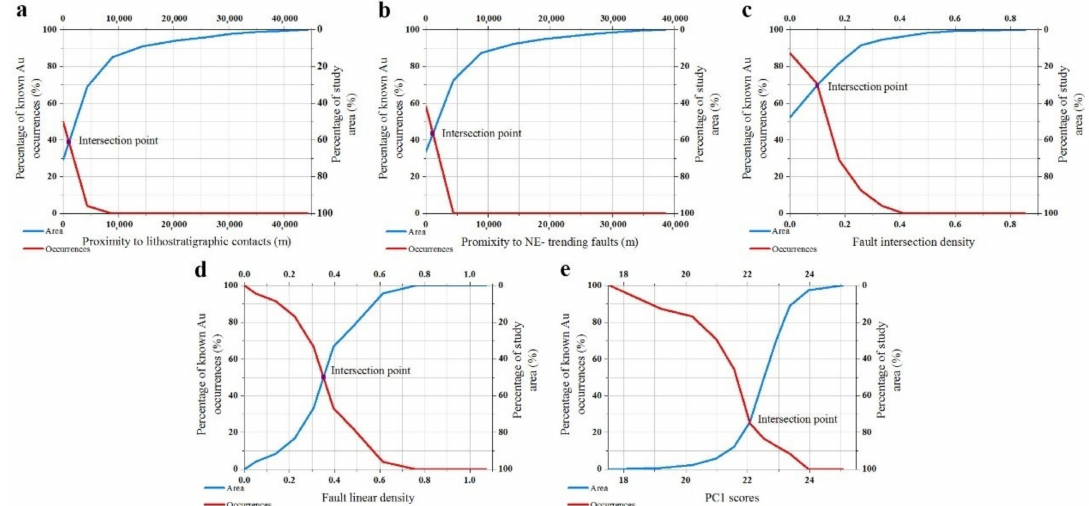
Figure 6. Prediction-area (P-A) plots for evidence layers: ( a ) proximity to lithostratigraphic contacts; ( b ) proximity to NE-trending faults; ( c ) fault intersection density; ( d ) fault linear density; ( e ) PC1 scores generated by Ag, As, Au, and